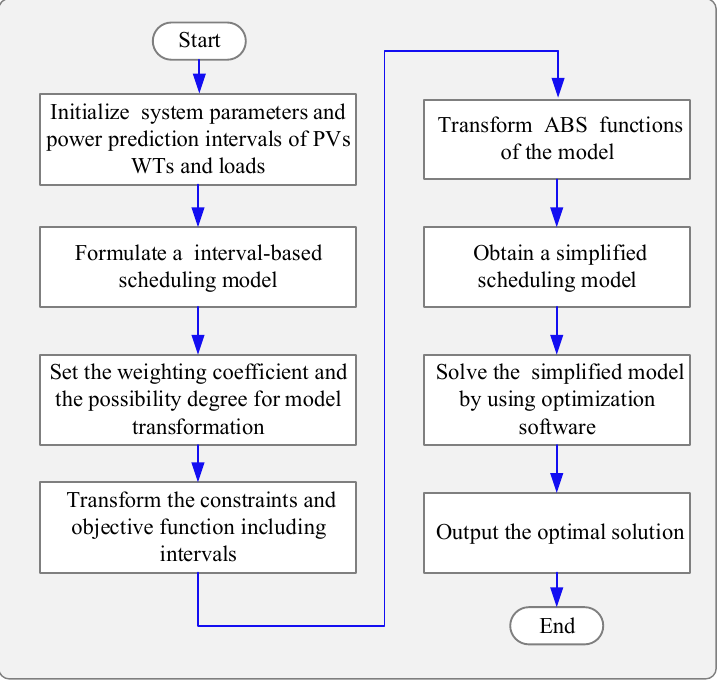
Figure 3. Flow chart for solving the interval-based optimization